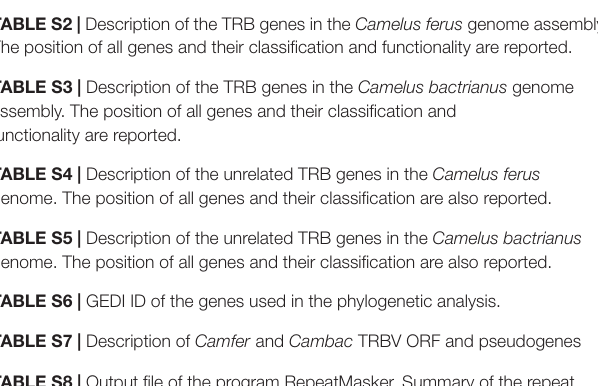
FIGURE S4 | Pip of the TRBV region between dromedary, wild and domestic Bactrian camels. The dromedary sequence is shown on the horizontal axis, and the percentage identity to the wild (Camfer) and domestic (Cambac) Bactrian camels are shown on the vertical axis. The position and orientation of all the genes and repetitive sequences are indicated. The horizontal lines represent the ungapped alignments at the percentage similarity corresponding to the scale on the right. TABLE S1 | Scaffolds of the camel genomic assemblies used in the analysis. TABLE S2 | Description of the TRB genes in the Camelus ferus genome assembly. The position of all genes and their classification and functionality are reported. TABLE S3 | Description of the TRB genes in the Camelus bactrianus genome assembly. The position of all genes and their classification and functionality are reported.